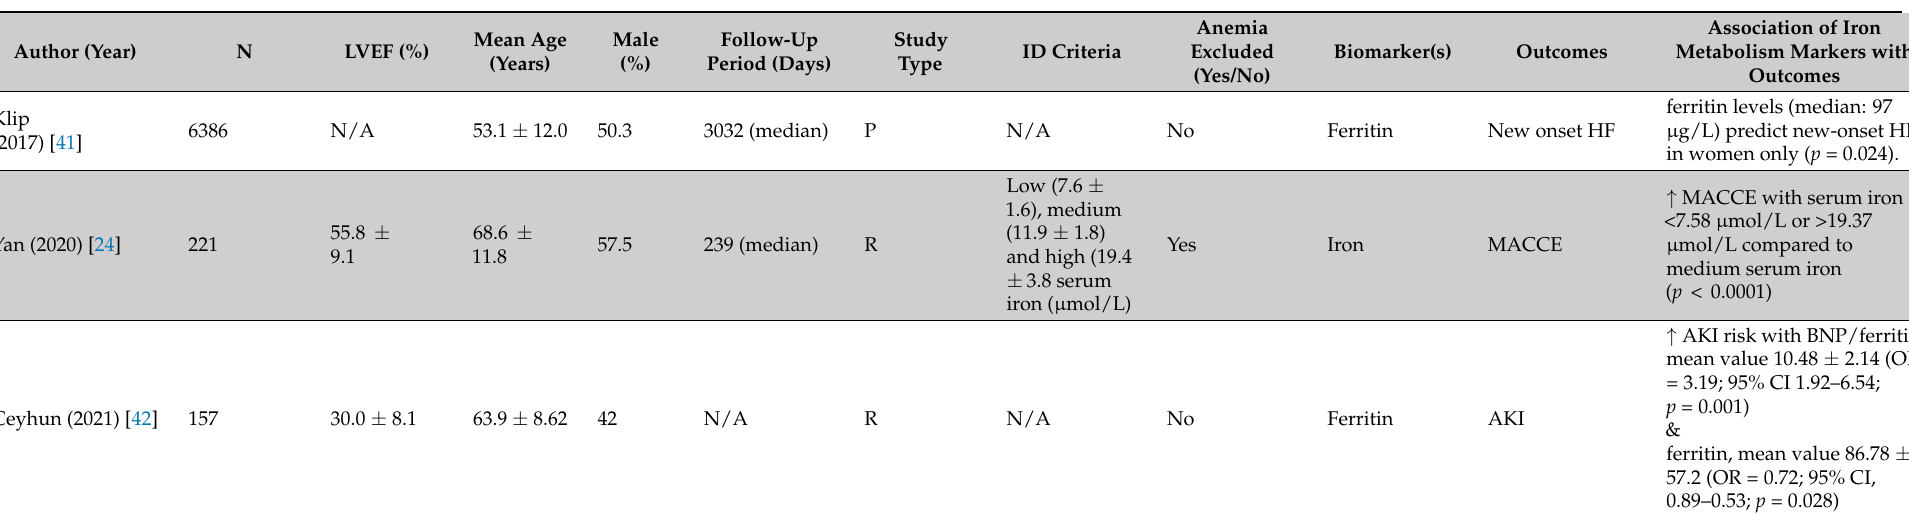
Table 4. Characteristics of Studies Associating Biomarkers of Iron Metabolism with Additional Adverse